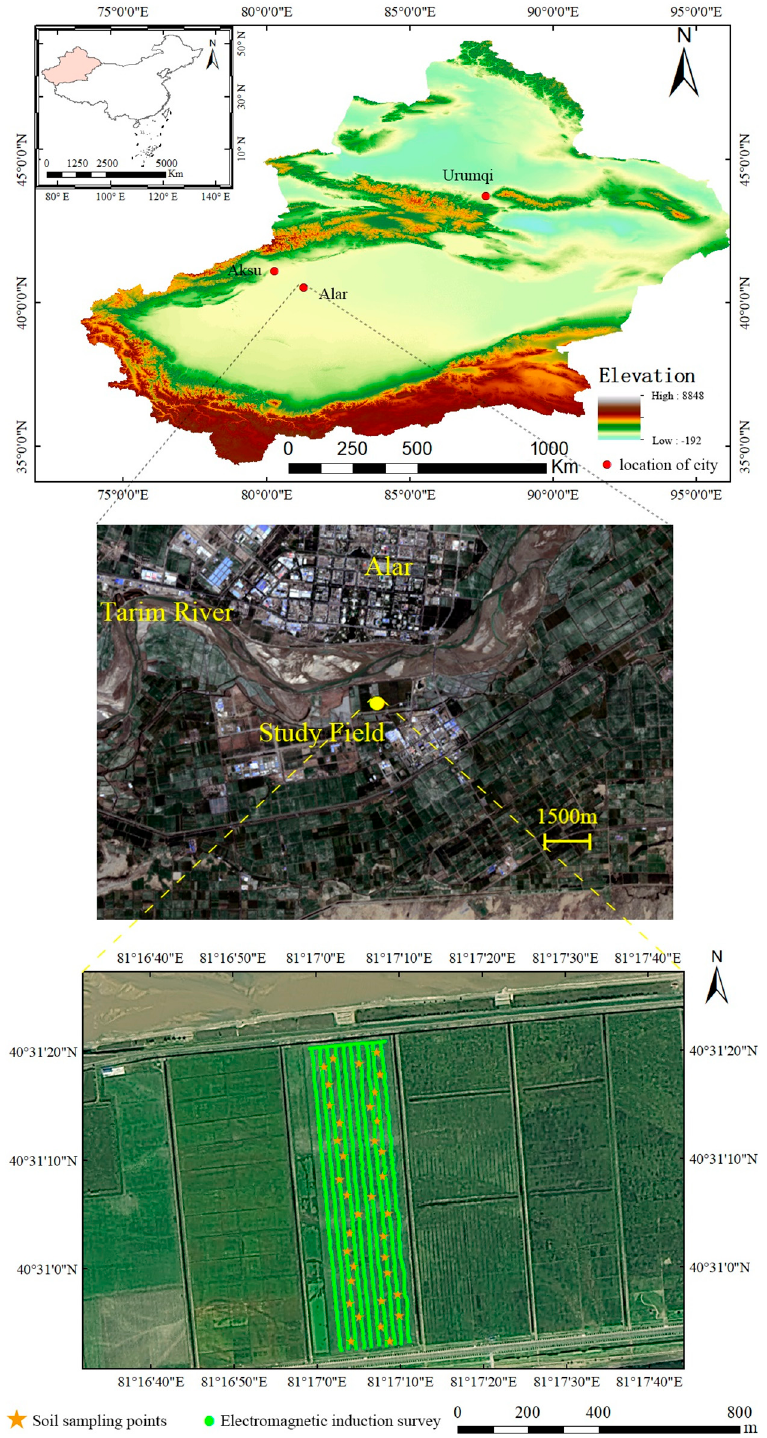
Figure 1. Location of study area, sampling points of electromagnetic induction survey. and soil sam- pling.